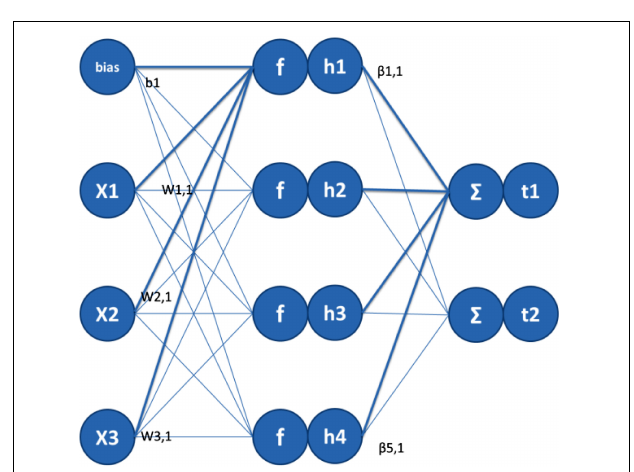
FIGURE 3 | Motion image recognition process based on